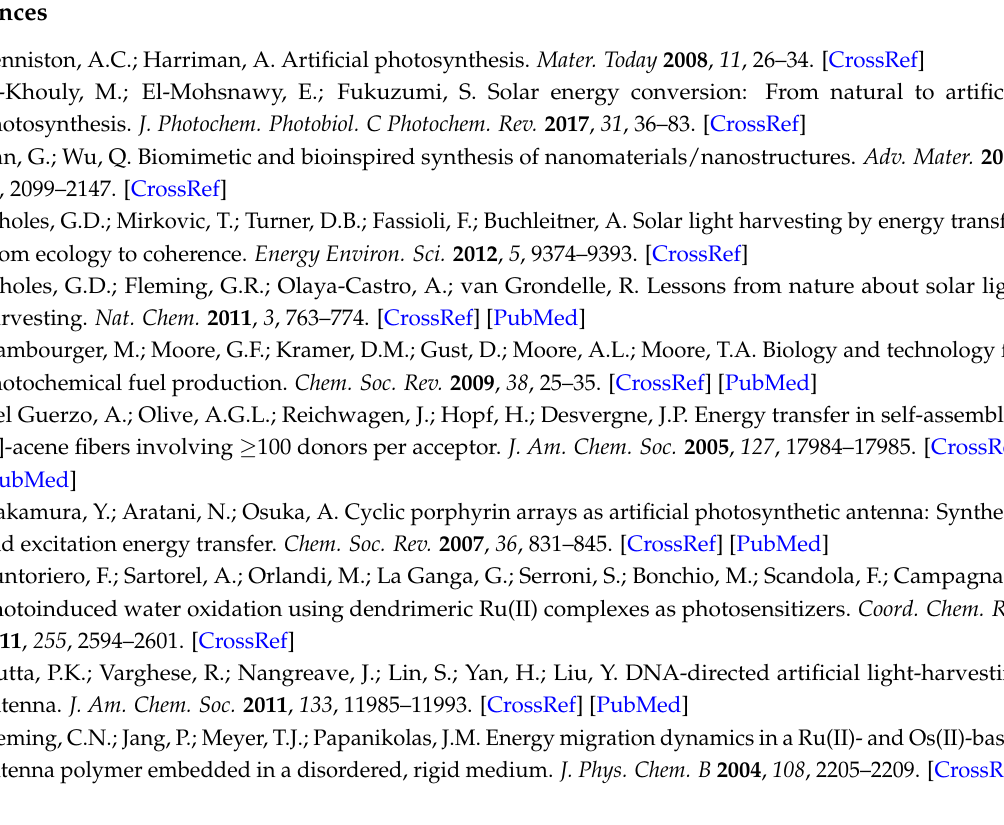
Figure S1 to S3: Spectral overlaps between energy donor and acceptor enabling FRET in each tested dye